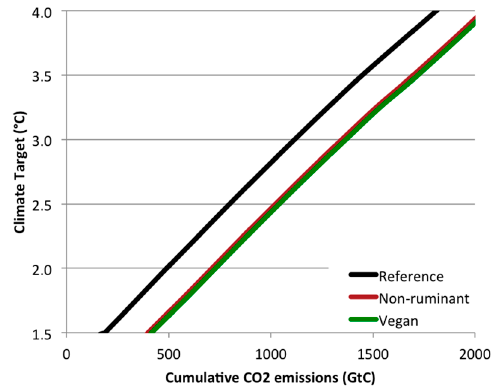
Figure 2. Temperature change as a function of cumulative CO 2 emissions beyond 2010, depending on diet. All scenarios use the same optimistic assumptions on developments in agriculture regarding productivity and mitigation measures.